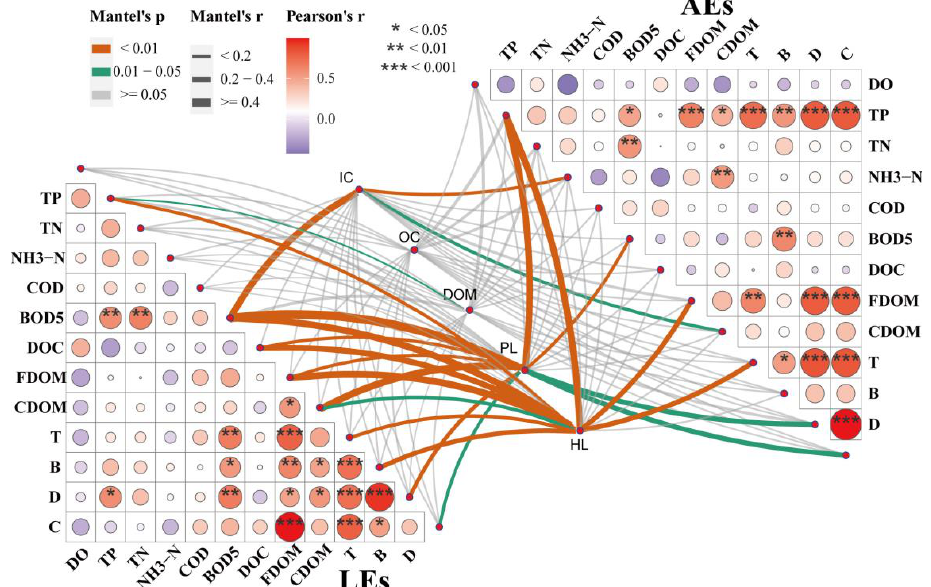
Figure 6. The relationships between conventional water quality parameters (inorganic indicators (IC), organic indicators (OC)), DOM, and fluorescence peaks (protein-like peaks (PL) and humus-like peaks (HL)) were observed in AEs and LEs. The partial Mantel test was applied using the ‘ggcor’ R package. Mantel’s r (coefficient of correlation) indicates the correlation, in which the width of the line denotes the level of correlation and the color of the lines represents the p -value. A color and asterisk gradient show Spearman’s correlation coefficients and the statistical significance, respec- tively.